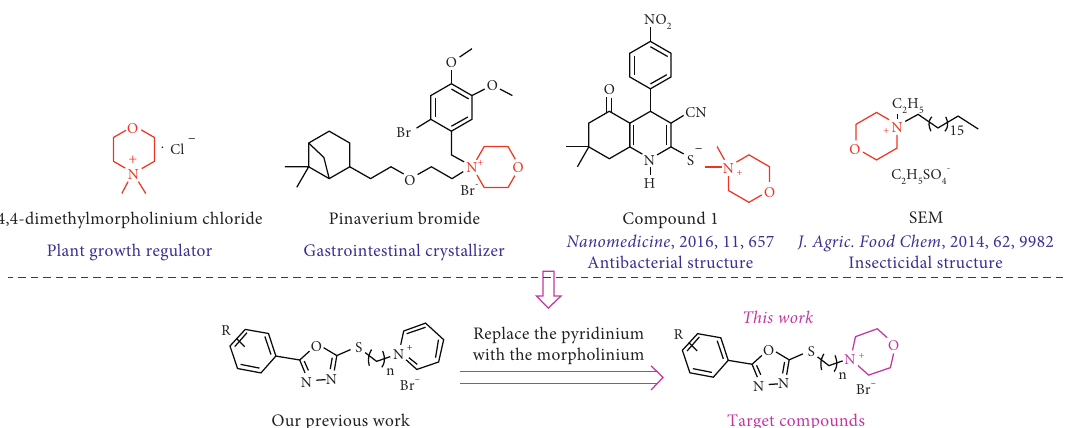
Figure 1: Bioactive structures containing the morpholinium moiety and the design strategy for target molecules in this